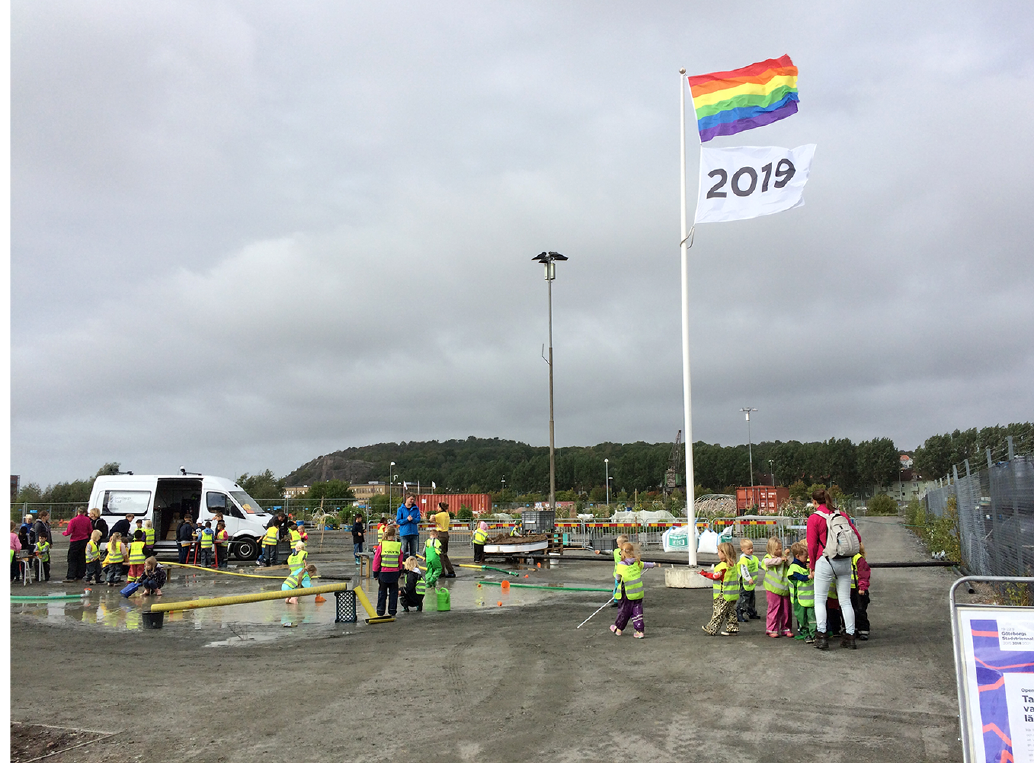
Figure 2. Open call with children: Investigating what a future playground could be in scale 1:1 (2018). Photo: Ida